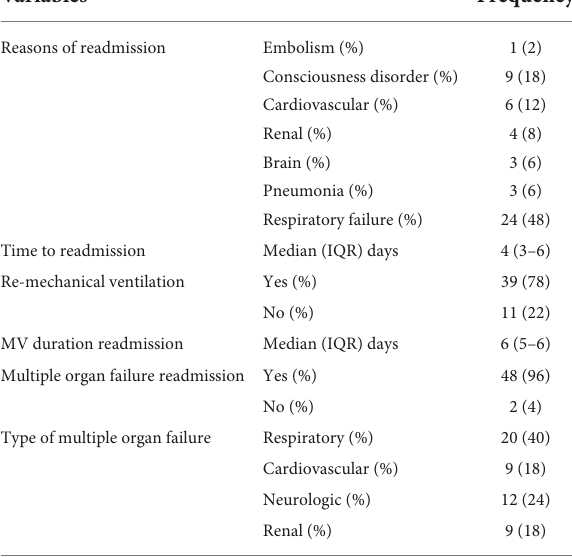
TABLE 2 Clinical characteristics of patients readmitted to the ICU ( n = 50).